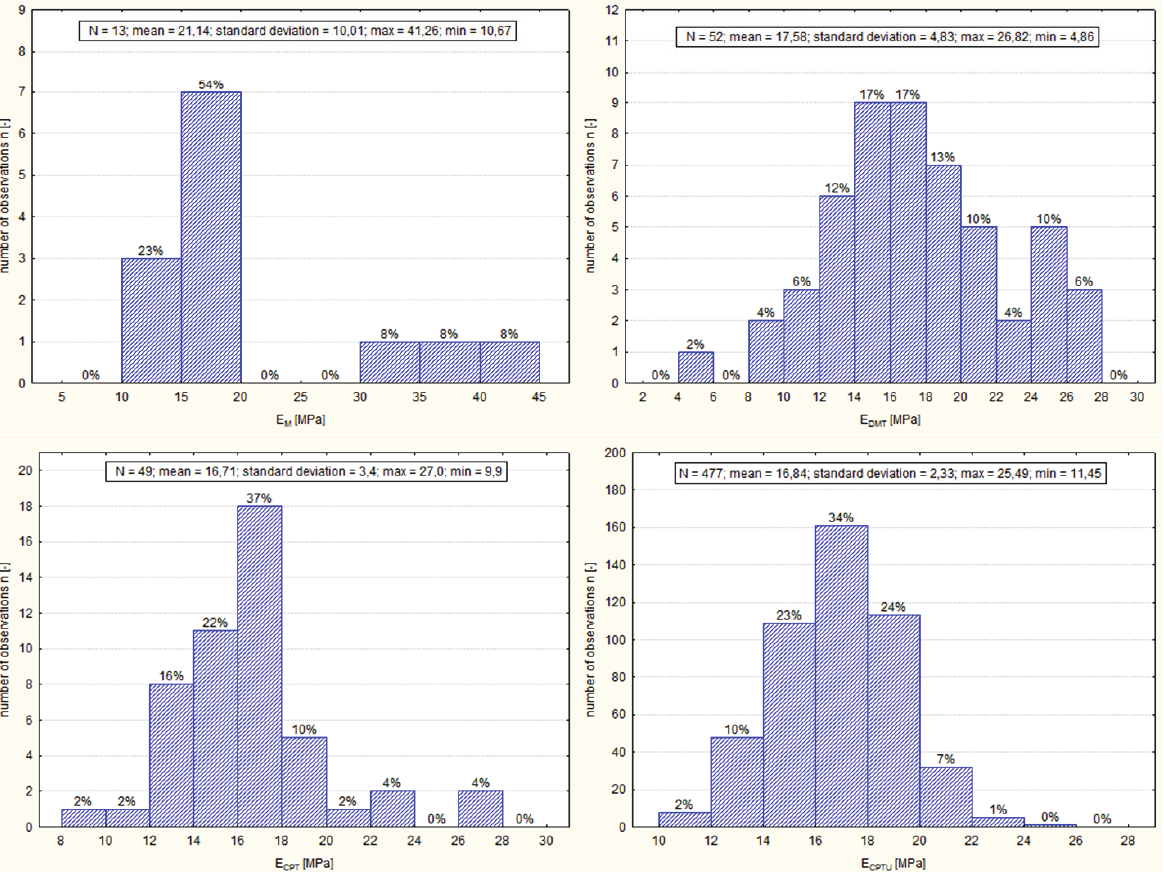
Fig. 6. Frequency and percentage of deformation modulus E in different